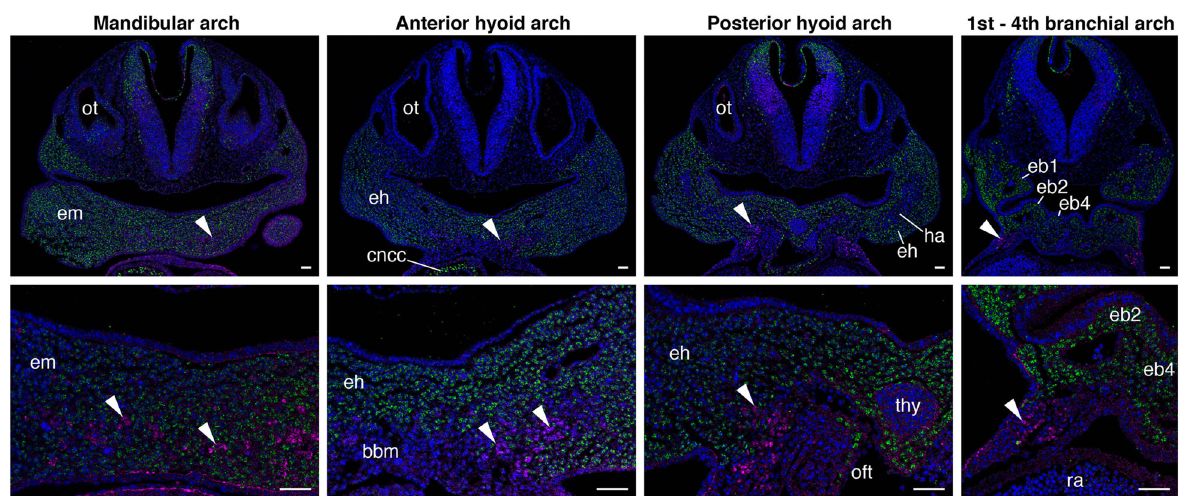
Fig. 3 Trajectory of HBM precursors in mouse embryos. Transverse sections of mandibular, hyoid and branchial arch levels in Wnt1-Cre/ R26R-H2B-EGFP embryos at stage E10.5. Bottom panels show the magnification of pharyngeal floor. Arrowheads indicate HBM precursors. PAX3 protein was detected on both sides of the EGFP-negative basibranchial mesenchyme and laterally surrounded by EGFP-positive neural crest cells at the hyoid arch. Bbm, basibranchial mesenchyme; cncc, cardiac neural crest cells; eb1 – 4, ectomesenchyme of first to fourth branchial arch; eh, ectomesenchyme of hyoid arch; em, ectomesenchyme of mandibular arch; ha, hyoid arch mesoderm; oft, outflow tract; ot, otic vesicle; ra, right atrium; thy thyroid gland. Scale bars, 50 μ